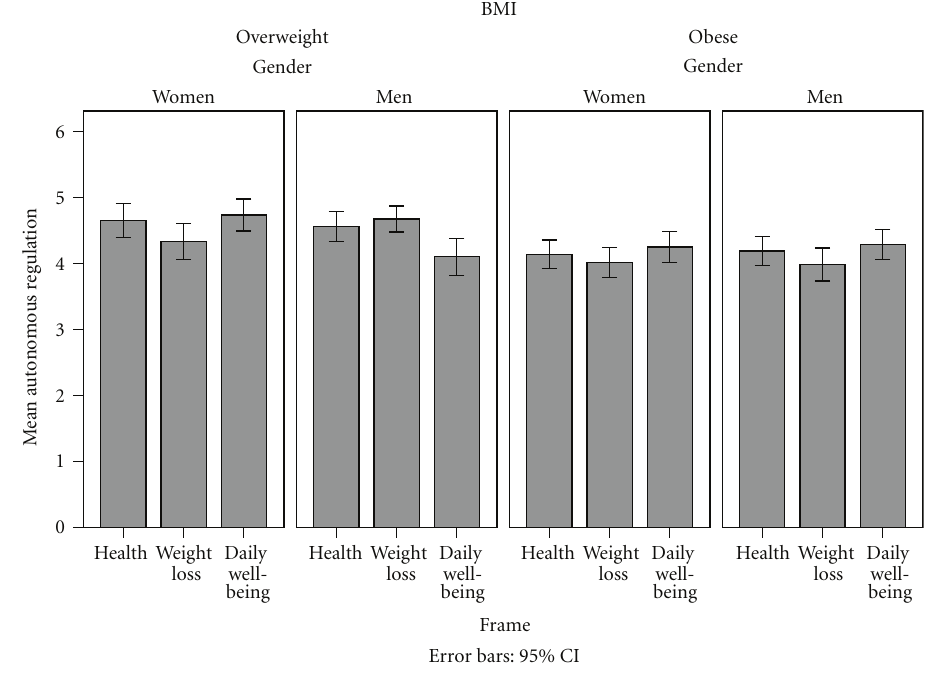
Figure 3: Autonomous